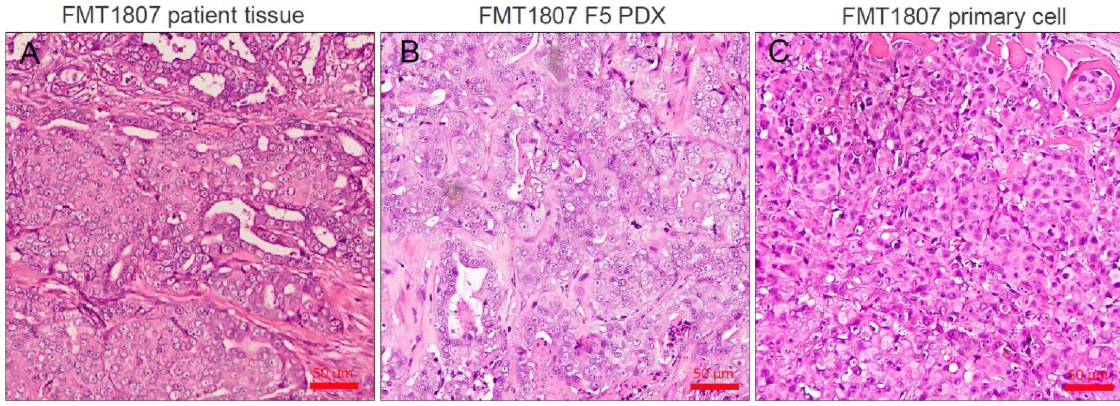
Figure 1. Histological examples of FMT PDXs. H&E staining was used to assess tumor structure of original patient samples ( A ), FMT1807-PDX ( B ) and primary FMT1807 cells implantation ( C ) samples. Bar = 50 μm.